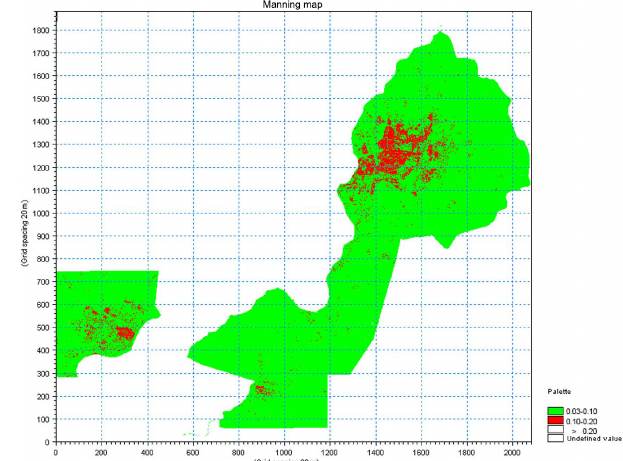
Figure 4. Distribution of Manning roughness coefficients.